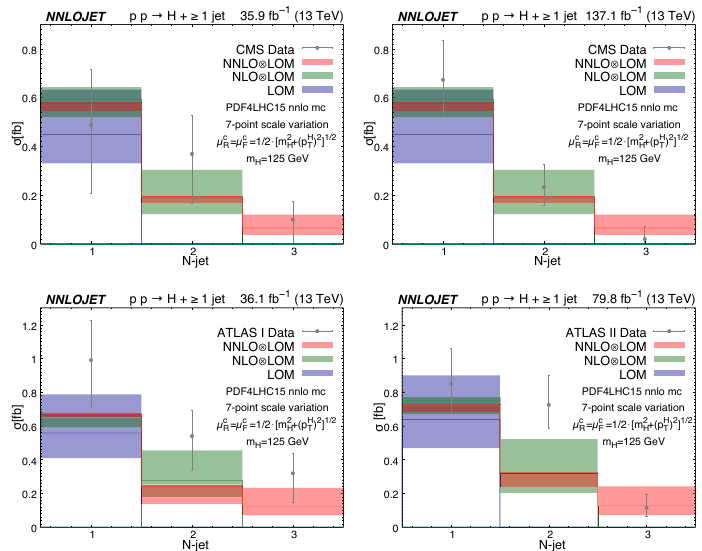
dt =35.9 fb − 1 ] L (cid:31) dt =36.1 fb − 1 ] (lower-left) and L